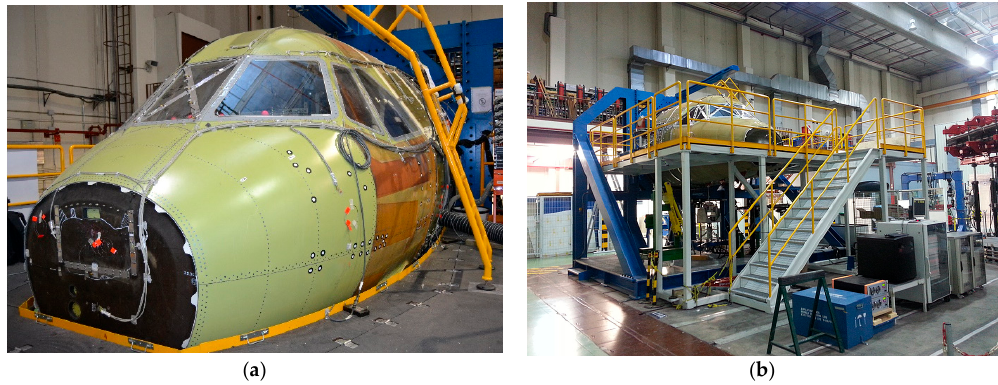
Figure 1. Clean Sky/Green Regional Aircraft MT2 cockpit demonstrator ( a ) and test rig ( b ) developed by Airbus Defence and Space.